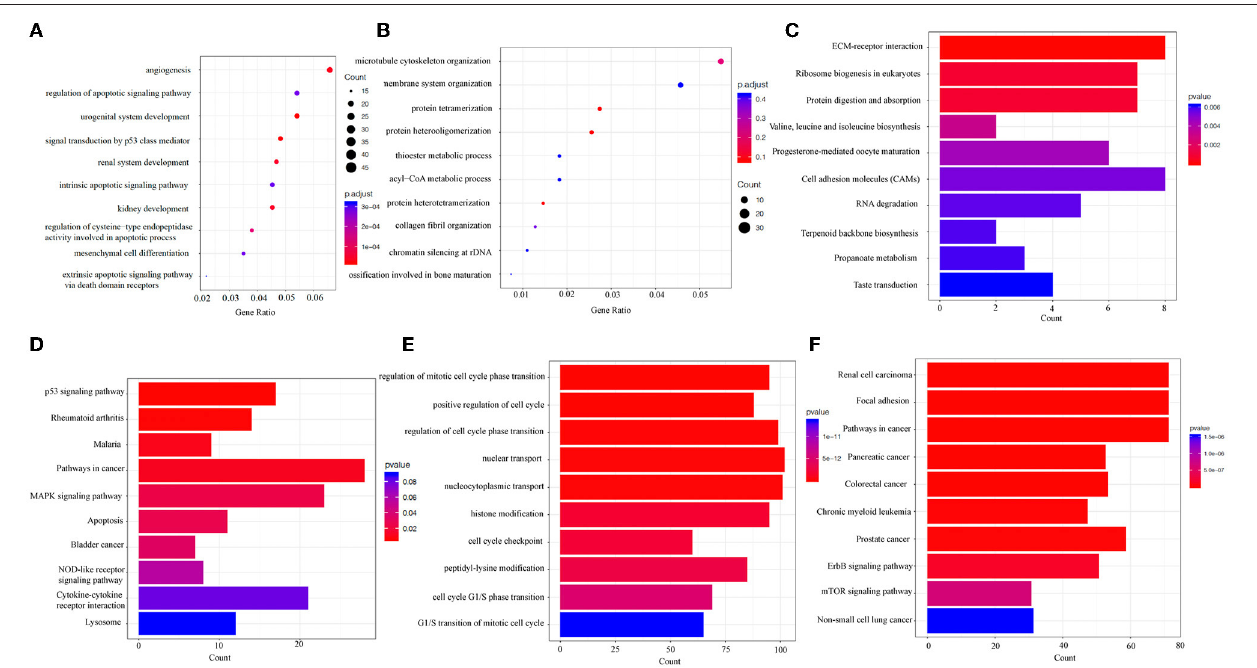
FIGURE 4 | The Gene Ontology (GO) and the Kyoto Encyclopedia of Genes and Genomes (KEGG) analyses reveal the biological information behind the differences in mRNA expression levels and m 6 A methylation modification. (A,B) The top 10 enriched GO terms of upregulated and downregulated DEGs. (C,D) The top 10 enriched KEGG pathways of upregulated and downregulated DEGs. (E,F) The top 10 enriched GO terms and KEGG pathways of DMGs. DEGs, differentially expressed genes. DMGs, differentially methylated genes. “Gene ratio,” number of genes annotated to the specific GO term/number of all the genes with the GO database annotations. “Count,” number of genes annotated to the specific GO